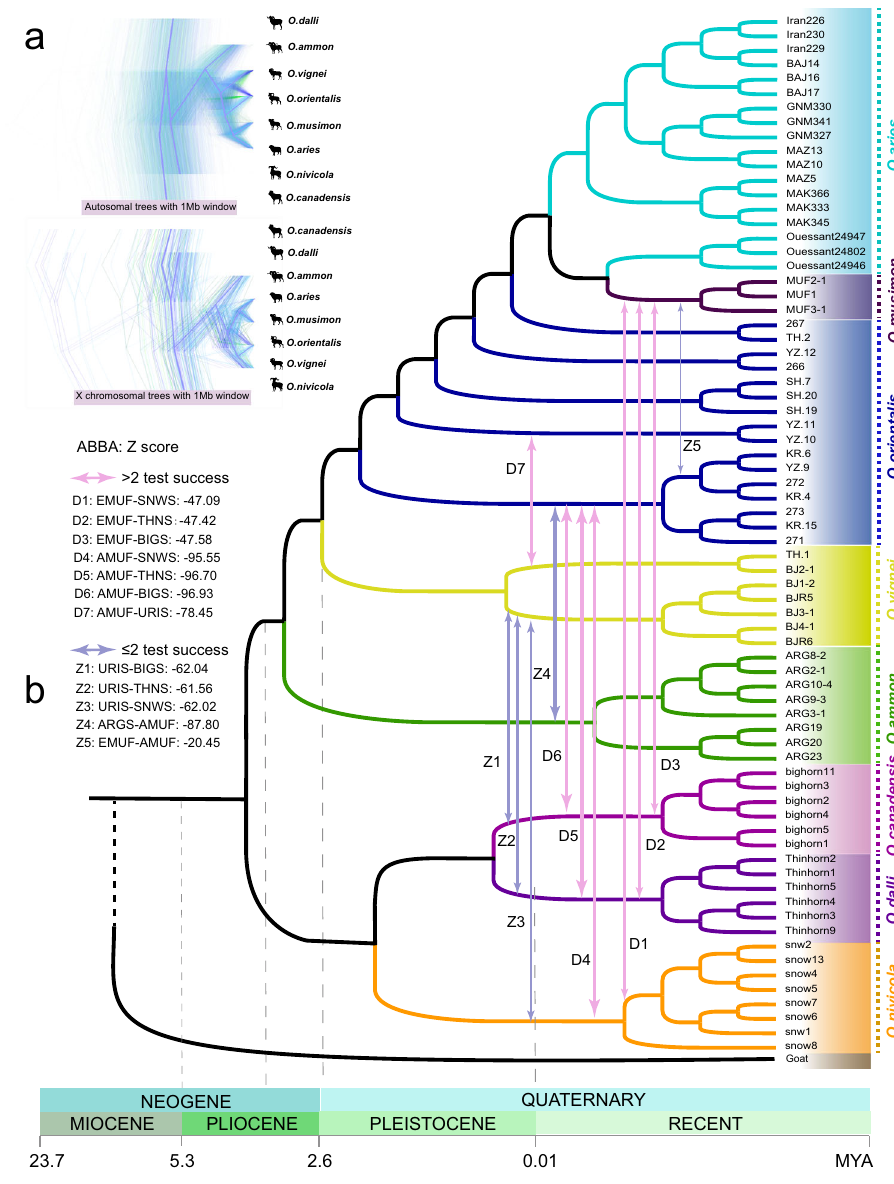
Fig. 2 Phylogeny of Ovis genus. a Prevalent discordance among segmental trees on autosomes and X chromosome, totaling 2598 1-Mb segments. The segmental trees were visualized by Densitree. Consensus tree topologies of each category are shown in purple. b Phylogenetic tree of the whole autosomal coding region (CDS) of the 72 individuals using RAxML. Arrows marked the introgression pairs and the corresponding Z -score based on the D -statistics, see Supplementary Data 4. Pink arrows indicate the admixed pairs which have been selected by three or more of the tests such as D -statistics, TreeMix, f - statistics, and admixture analysis, while purple arrows indicate the introgression pairs detected in two or less of the tests. Here, EMUF is European mou fl on ( O.musimon ), AMUF is Asiatic mou fl on ( O.orientalis ), URIS is urial ( O.vignei ), ARGS is argali ( O.ammon ), SNWS is snow sheep ( O.nivicola ), BIGS is bighorn sheep ( O.canadensis ), and THNS is thinhorn sheep ( O.dalli ). Source data for a were presented in Supplementary Data